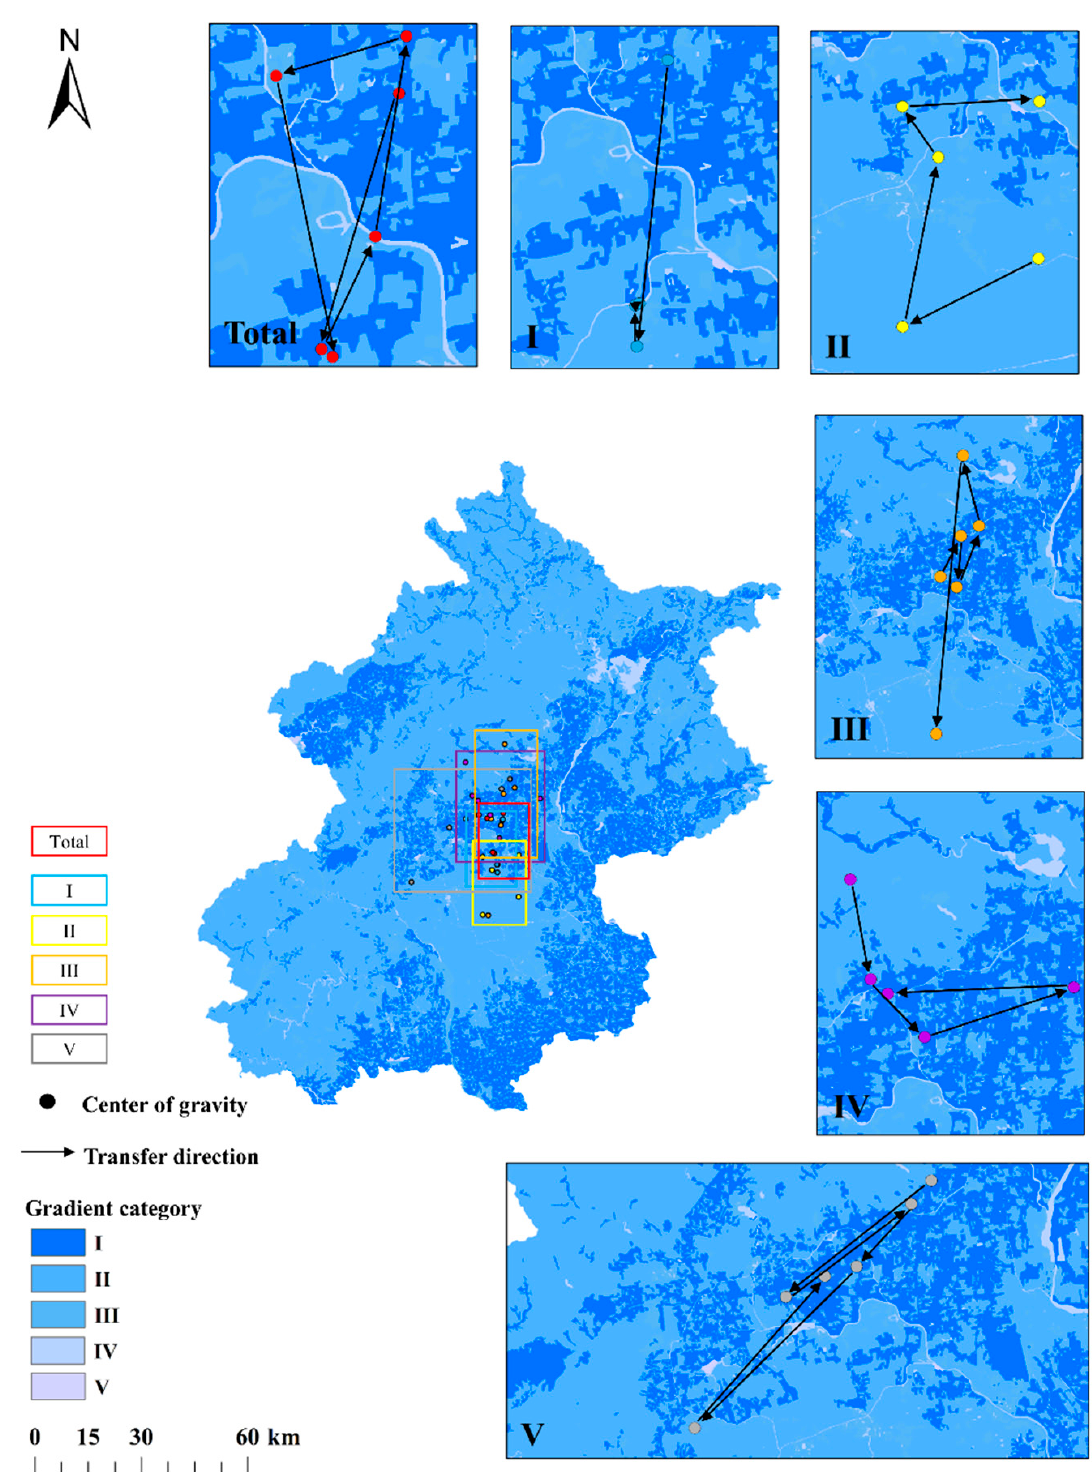
Figure 6. Changes in the location of the integrated gradient’s center of gravity. Note: Areas with gradient I disappeared from 2005 to 2010 and from 2015 to 2018; areas with gradients II or III disappeared from 1995 to 2000; Numbered rectangles refer to the gradient maps surrounding the overall map.